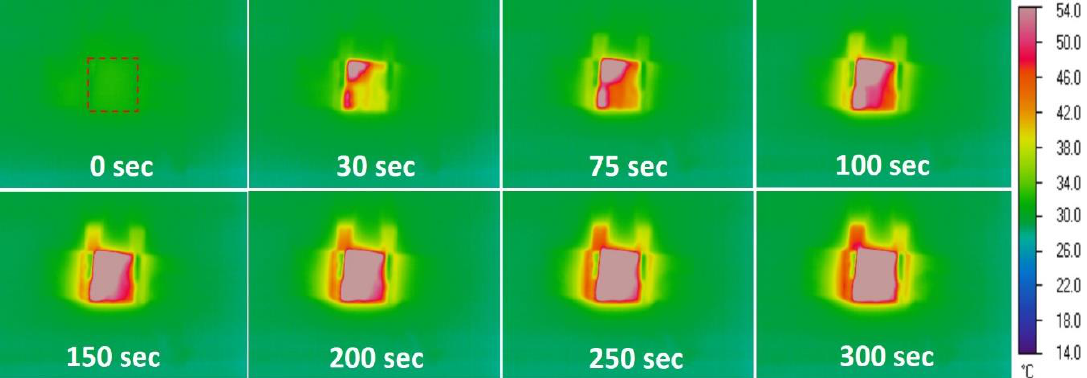
/ PU coating at 75 V. Nanomaterials 2020 , 10 , x FOR PEER REVIEW